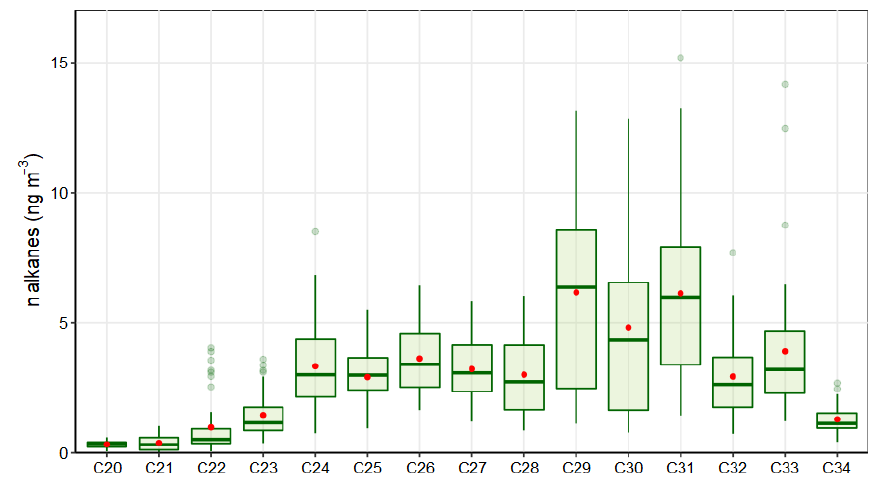
Figure 5. Average n alkanes concentrations in PM 2 . 5